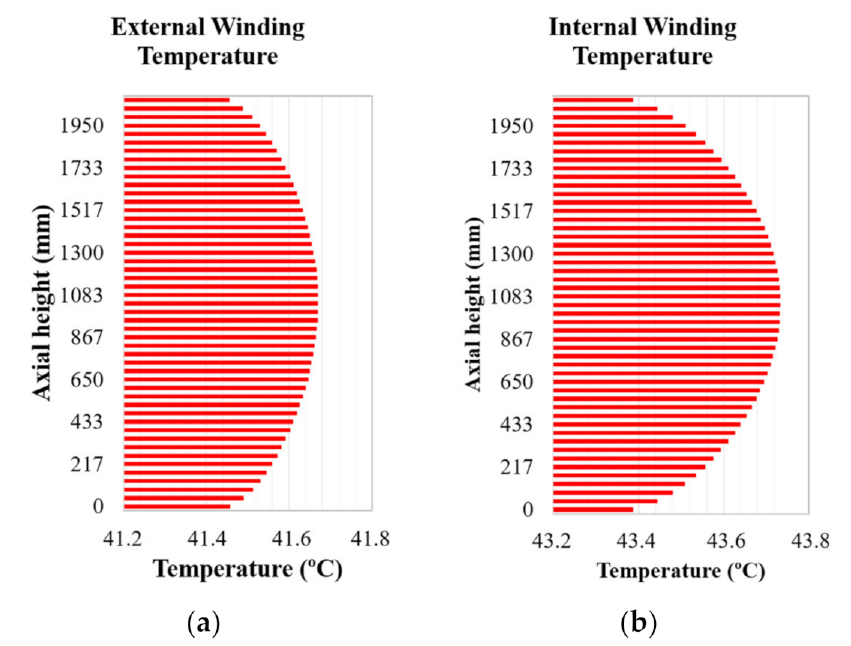
Figure 10. Heat flow in the windings ( a ) in external winding, ( b ) in internal winding.